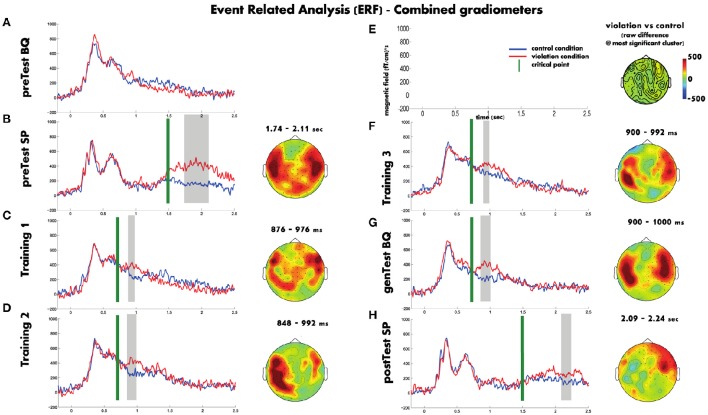
The plotted waveforms represent the averaged ERFs across all the sensors, the gray boxes the time windows where the cluster was significant and the topography plots show the raw difference between the violation and control conditions in those time windows. In order to simplify the visualization Figure 5 shows only the cluster with lowest p-value for each block. Blue waveforms correspond to the control condition, red waveforms to the violation condition. Green vertical line denote the average critical point of each block. Gray boxes indicate statistically significant time windows. The topography plots show the raw difference between the violation and control for the cluster with the most supporting evidence of that block. Blocks appear on the order they were run (A–H), with the scales given in (E).